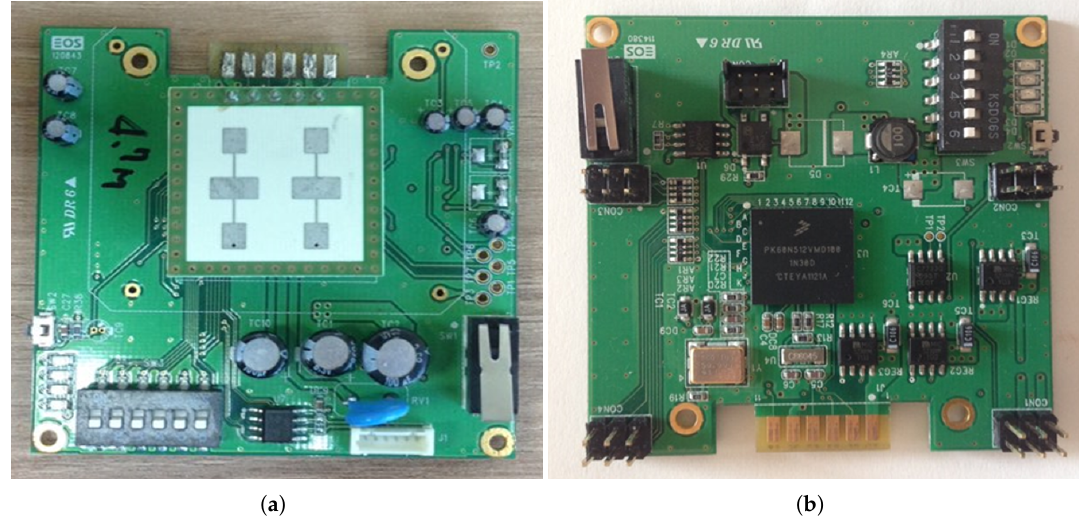
Figure 4. Twenty-four GHz Doppler radar sensor board implemented in this research. ( a ) Front; ( b )